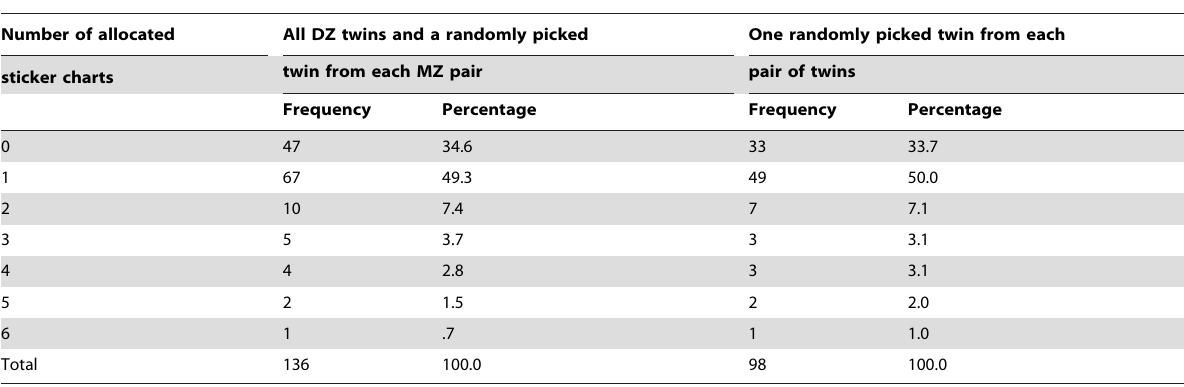
Table 2. Distributions of Allocated Sticker Charts in Two Subsamples.